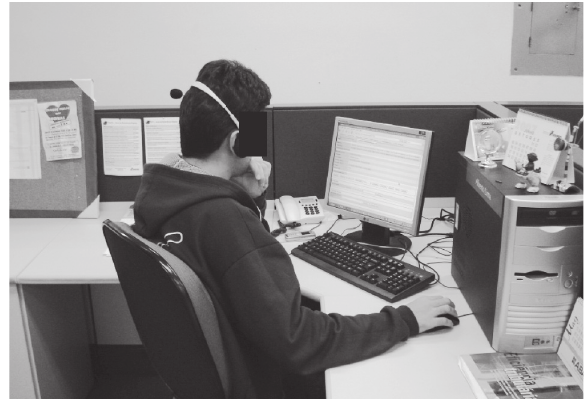
Figura 2 - Mobiliário de trabalho (monitor baixo, ou seja,